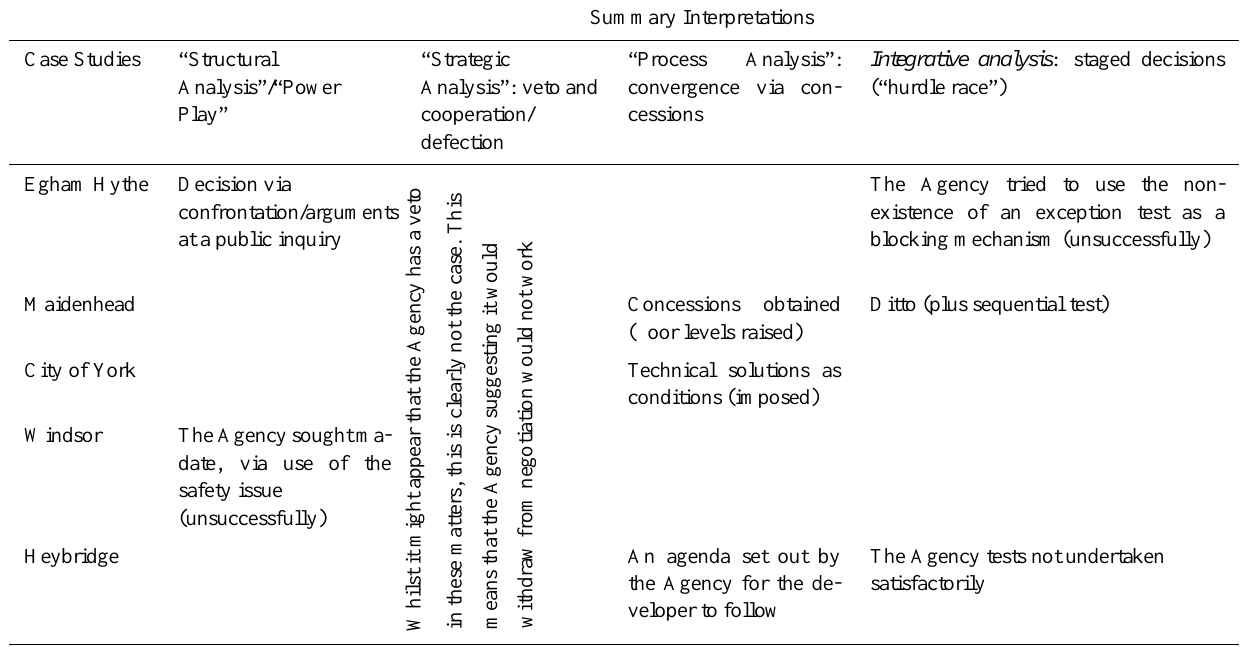
Table 2. Summary interpretations of the negotiation